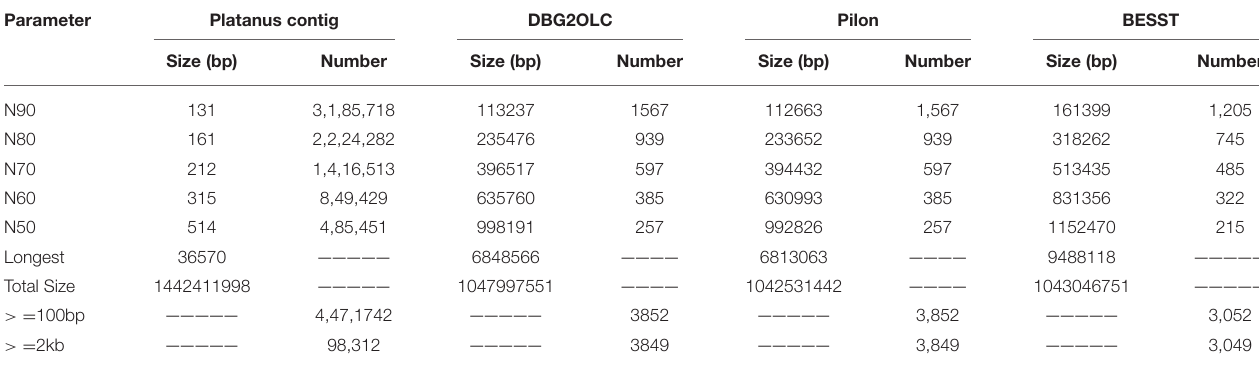
TABLE 1 | Statistics of our genome assembly. Parameter